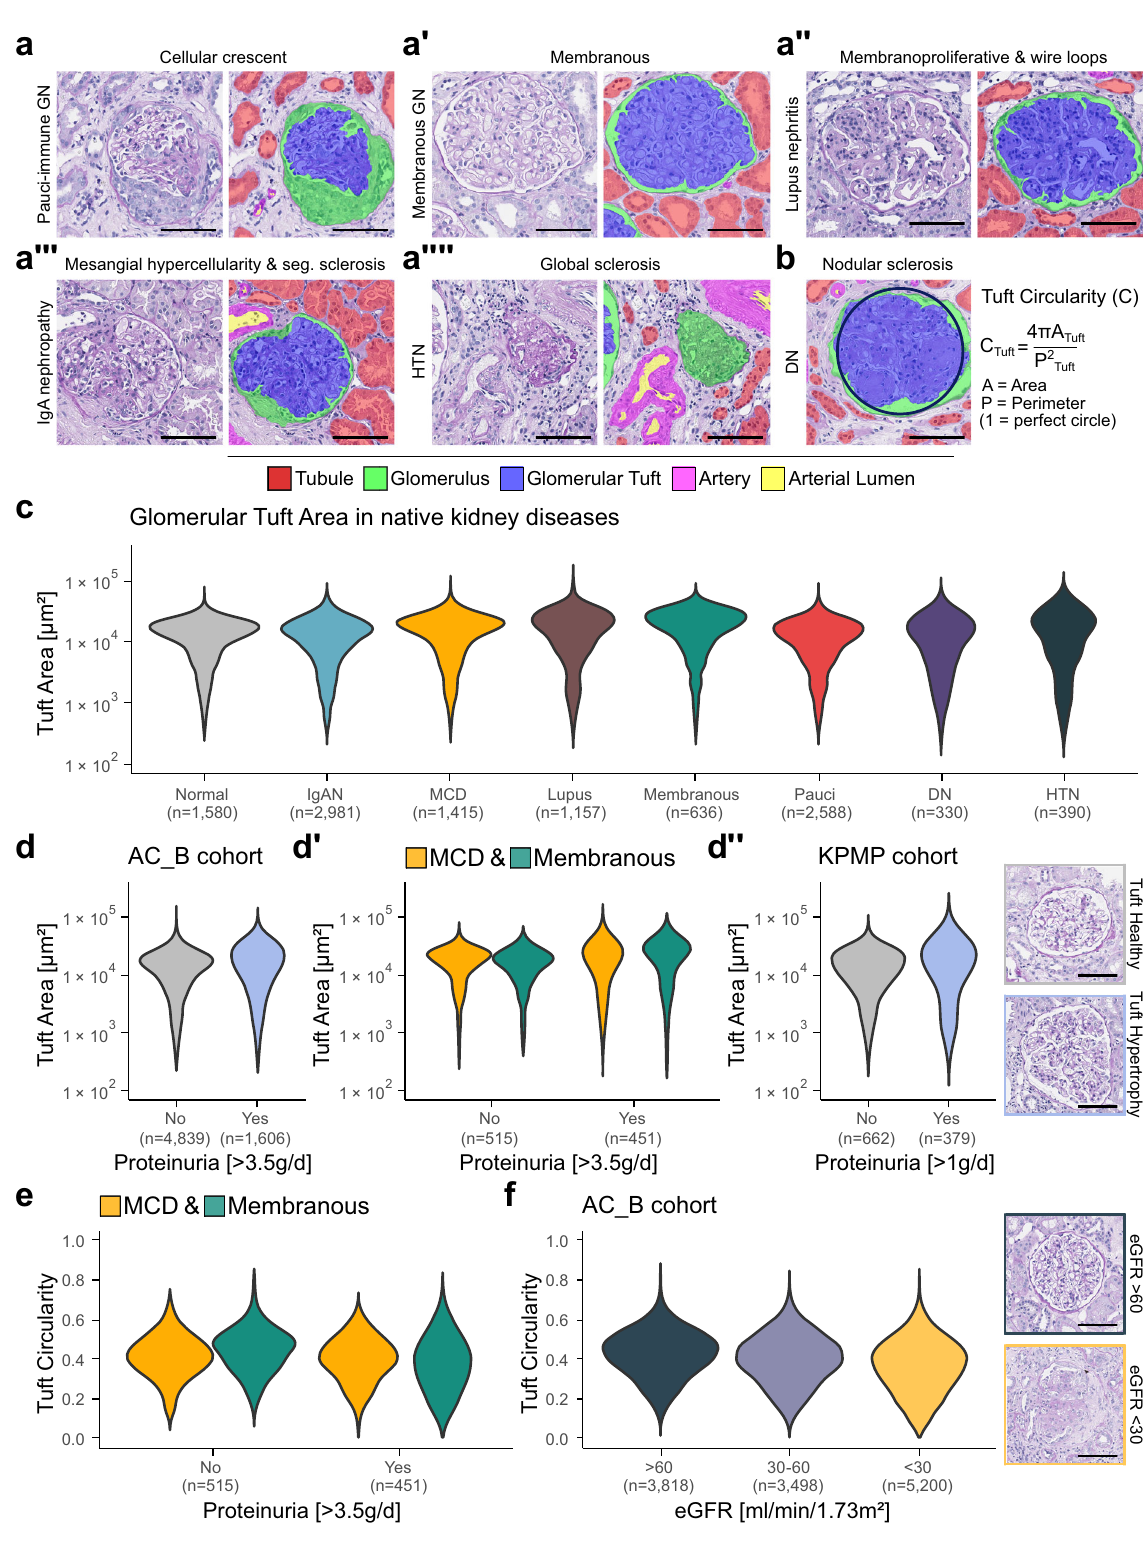
Morphometry of the tubulointerstitium and vasculature is linked to kidney function & hypertension kidneydiseases,FLASHwasusedtoextractfeaturesofovertwomillion